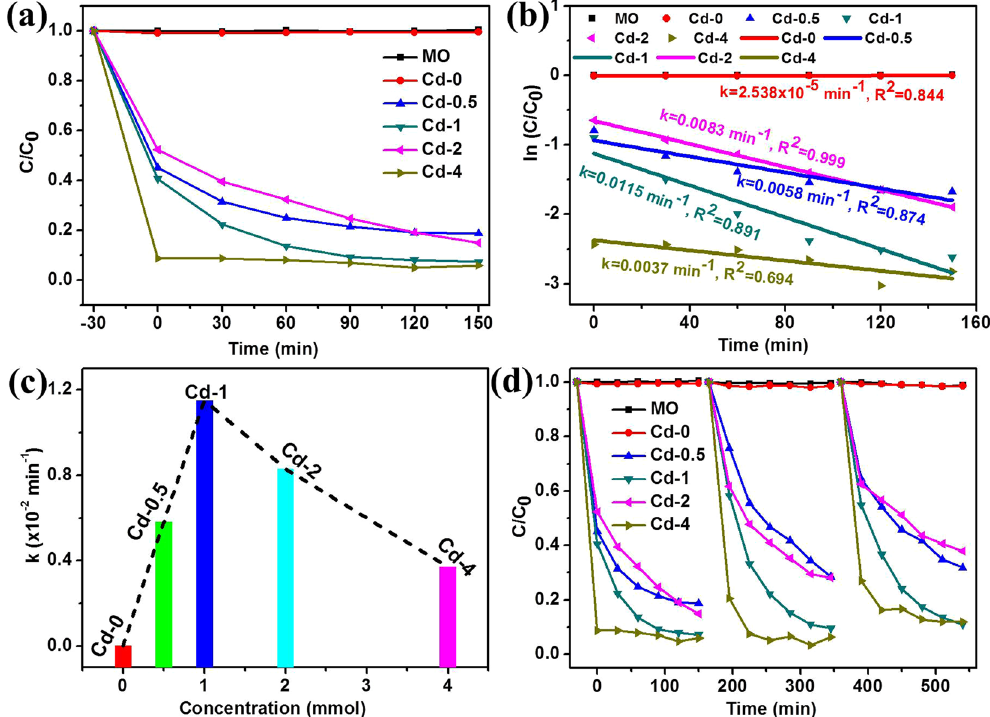
Figure 8. ( a ) Relative concentration ( C/C 0 ) of MO versus time under visible light irradiation using the samples prepared by different amounts of CdCl 2 . ( b ) The corresponding plots of ln( C/C 0 ) vs . time of the data in ( a ). ( c ) The kinetics plots of rate constant ( k ) vs . CdCl 2 concentration during the preparing process for samples Cd-0, Cd-0.5, Cd-1, Cd-2, and Cd-4. Dots and lines in ( b ) stand for original and linear fitting data, respectively. ( d ) Cycling test of all photocatalysts in the photodegradation of MO under visible light